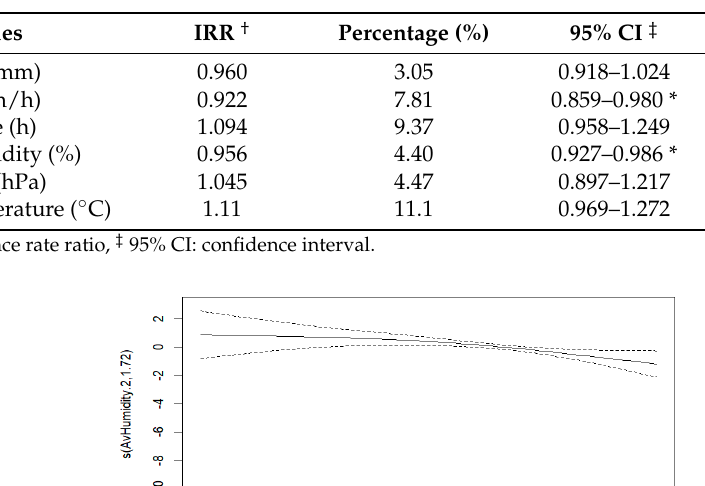
Table 4. Results of the incidence rate ratio between climatic factors and dengue cases, Asuncion, Paraguay.